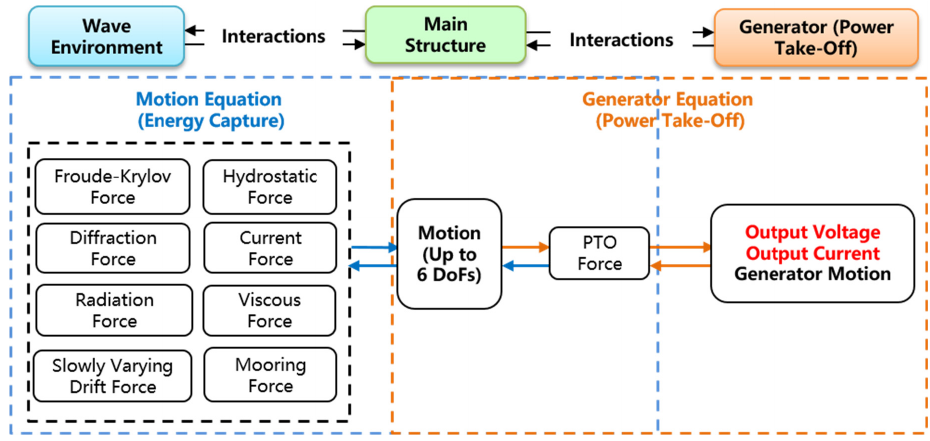
Figure 2. A mechanism diagram of a wave energy marine